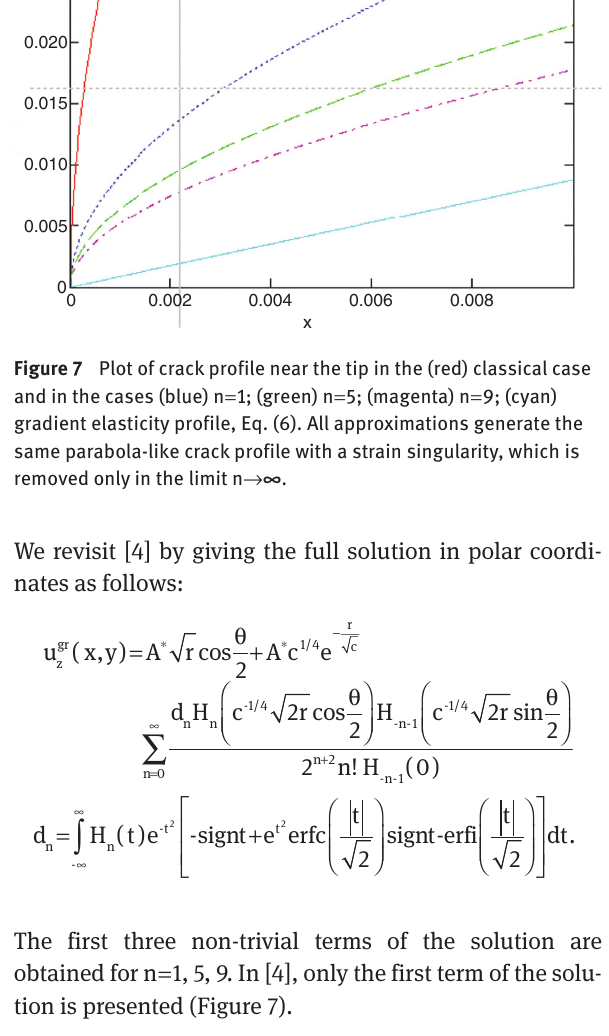
Table 1 Numerical estimate of gradient elasticity simplified σ . stress sim xy